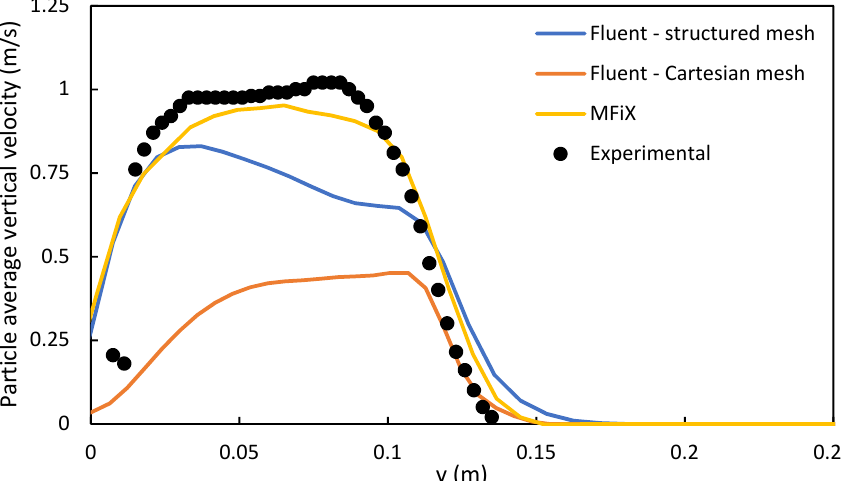
Figure 6. Time-averaged vertical profiles of the particles’ vertical velocity when employing the Di Felice drag model.